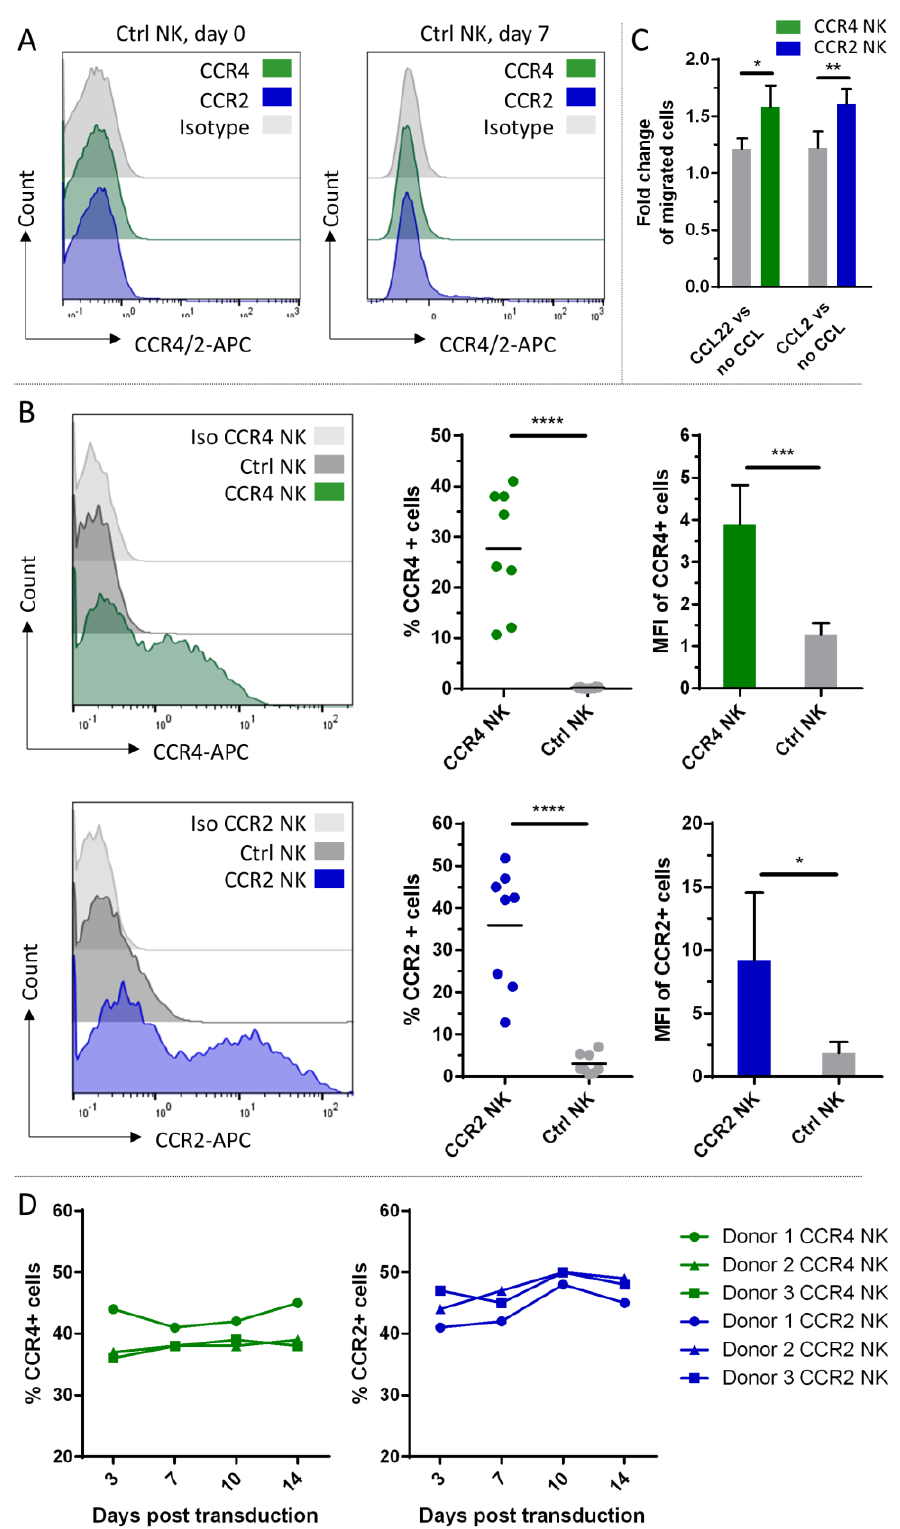
Figure 4. CCR4 or CCR2B expression on peripheral blood NK cells and functional testing of the genetically modified cells. ( A ) Freshly isolated NK cells from peripheral blood (day 0) and primary NK cells activated with IL-2 and IL-15 (day 7) were analyzed by flow cytometry for expression of CCR4 and CCR2B. ( B ) CCR4 or CCR2B expression was analyzed by flow cytometry on peripheral blood NK cells 7 days after transduction with CCR4- or CCR2B-encoding 𝛾 -retroviral particles. His- togram overlay shows the intensity of the APC signal of the CCR4/CCR2-specific antibody.